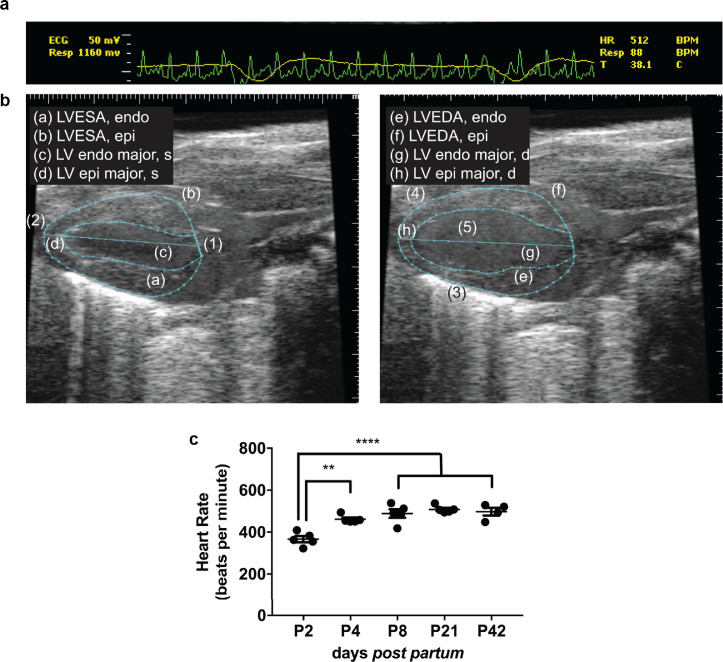
PLAX EKV B-mode imaging in neonatal mice. The adapted ultrasound setup allowed recording of electrocardiogram, respiration and temperature (a) and thereby to perform electrocardiogram-gated kilohertz visualisation (EKV) imaging on parasternal long axis (PLAX) B-mode imaging (b). (a) and (b) show representative traces of a mouse on post-natal day 2. The Vevo770 software was used to identify left ventricular end-systolic and end-diastolic areas of the endocardium (LVESA, endo [a], and LVEDA, endo [e]) and epicardium (LVESA, epi [b], and LVEDA, epi [f]), LV endocardial and epicardial majors at the end of systole (LV endo major, s [c] and LV epi major, s [d]) and at the end of diastole (LV endo major, d [g], and LV epi major, d [h]). Anatomic features are (1) aortic valve, (2) apex, (3) LV posterior wall, (4) LV anterior wall, (5) LV cavity. Heart rate was evaluated from this imaging modality (c).